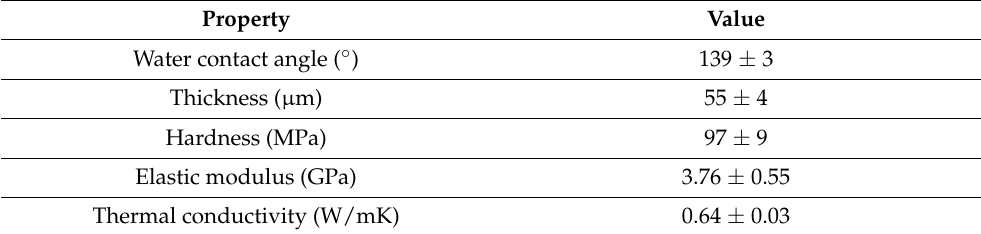
Table 6. Properties of UHMWPE nanocomposite coating reinforced with 0.1 wt.% of CNTs. Data From